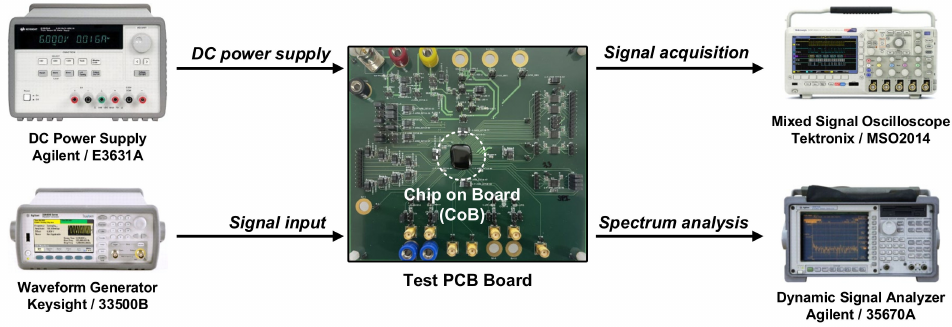
Figure 14. Measurement environment of the proposed CFIA with test